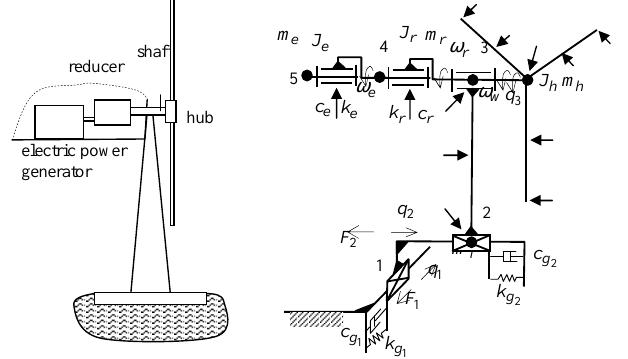
Figure 5. Example of motion simulation of constant speed WPG subject to ground